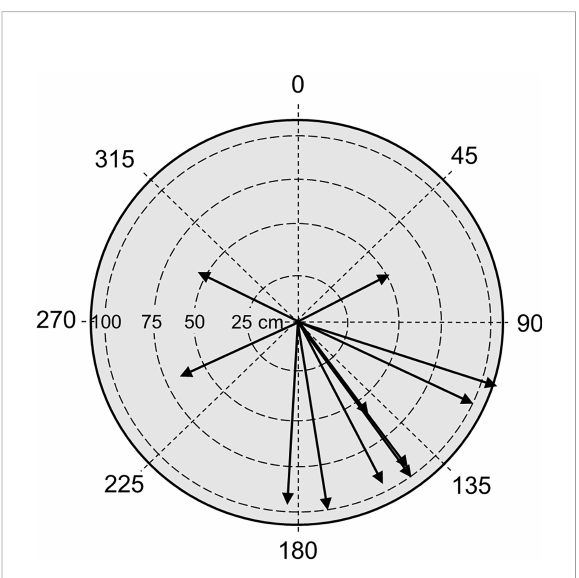
FIGURE 12 Bottom currents and wave action in the kelp forest. The direction of the arrows indicates the mean direction of the Laminaria ochroleuca blades (lamina) during wave movement. The length of the arrows indicates the distance the tip of the blades that were moved by the